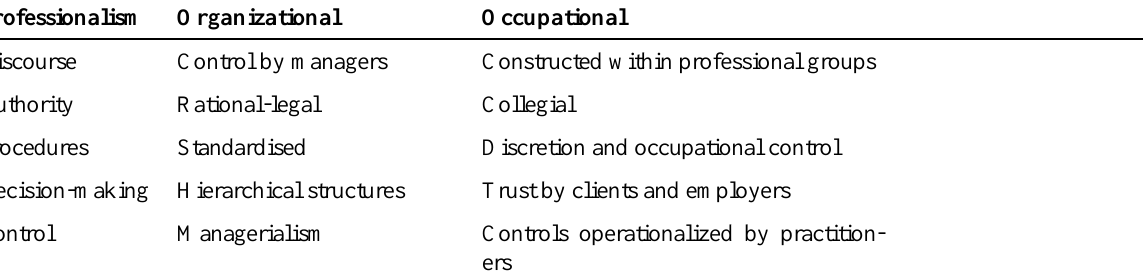
Table 1 Ideal types in knowledge-based work (based on the excerpts from Evetts, 2009, p.